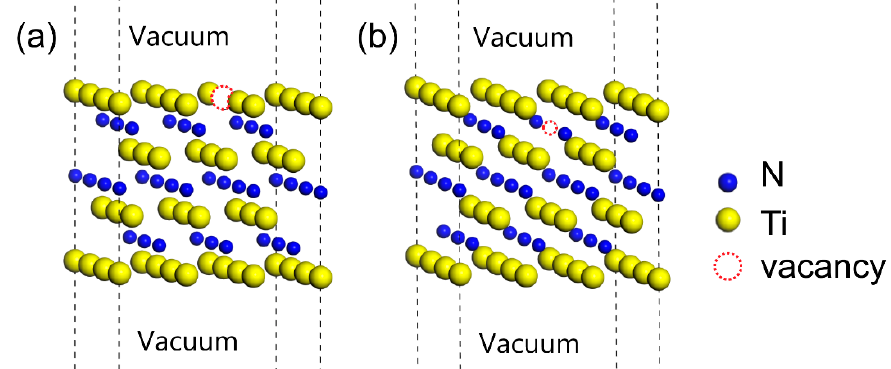
Figure 3. Schematic of a vacancy defect: ( a ) surface Ti-vacancy and ( b ) subsurface N-vacancy on a Ti 4 N 3 nanosheet.